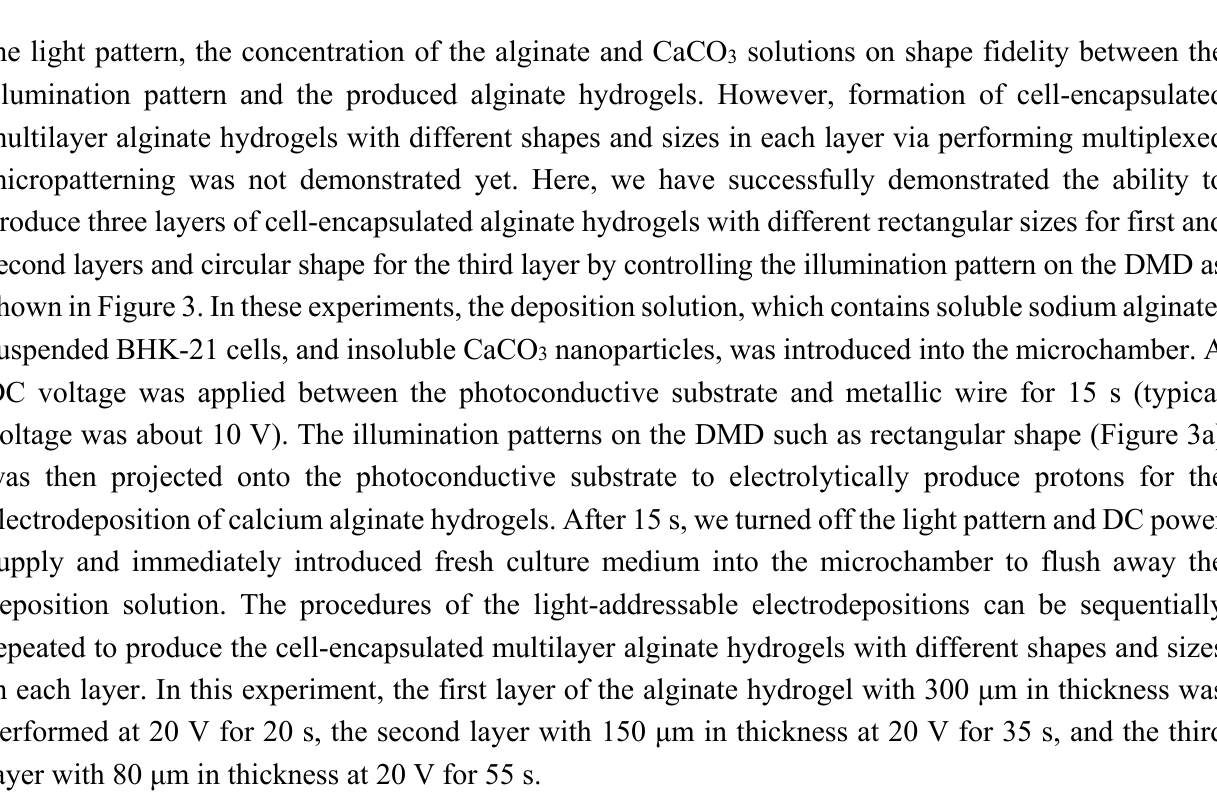
Figure 3. ( a ) Schematic diagrams of performing multiplexed micropatterning for formation of multilayer alginate hydrogels by controlling different illumination patterns in sequence. ( b ) Image of three layers of alginate hydrogels with different rectangular sizes for first and second layers and circular shape for the third layer. Three different colors of watercolor pigments were blended into the deposition solution for the purpose of easy observation. ( c ) The merged fluorescence image of the BHK-21 cells encapsulated in the second layer of rectangular alginate hydrogel (green, cells labeled with DiO dye) and the third layer of circular alginate hydrogel (red, cells labeled with DiI dye) at the regional area marked by dotted-line in ( b ) via performing multiplexed